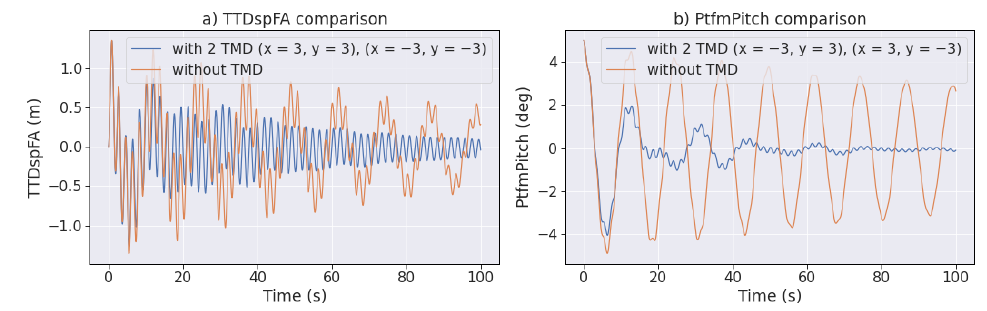
Figure 16. TTDspFA ( a ) and PtfmPitch ( b ) without TMD (orange line) and with two TMDs in the diagonal (blue